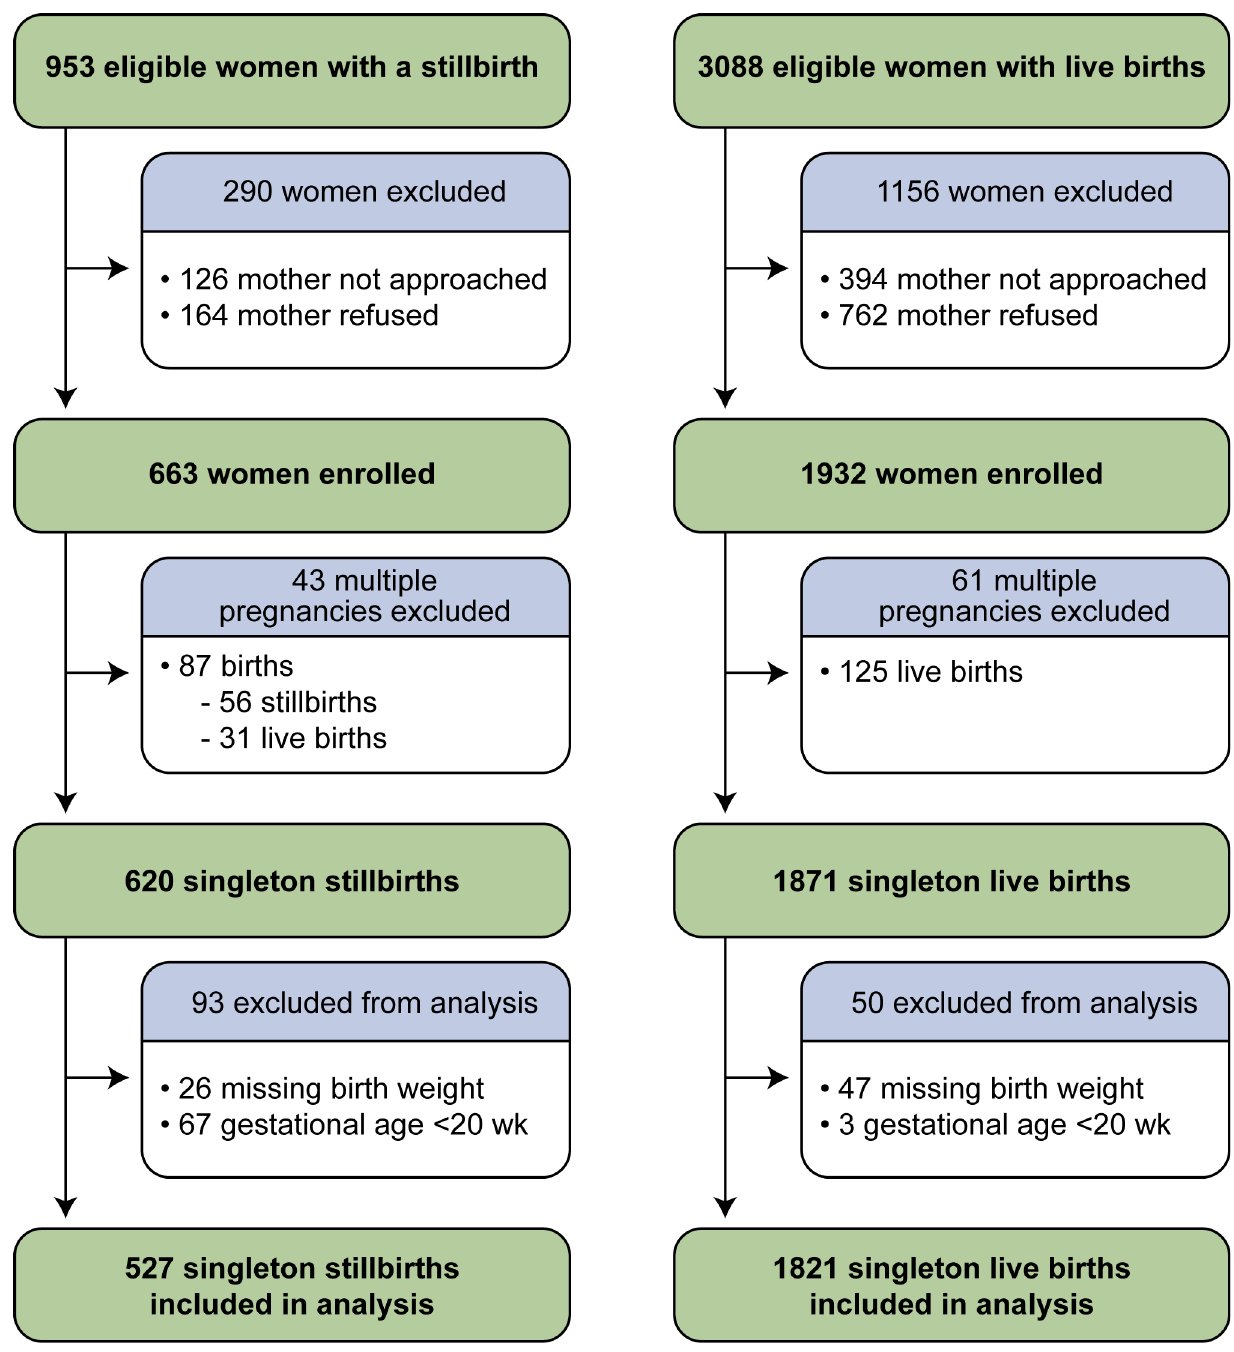
Figure 2. Study enrollment and inclusion in analysis.